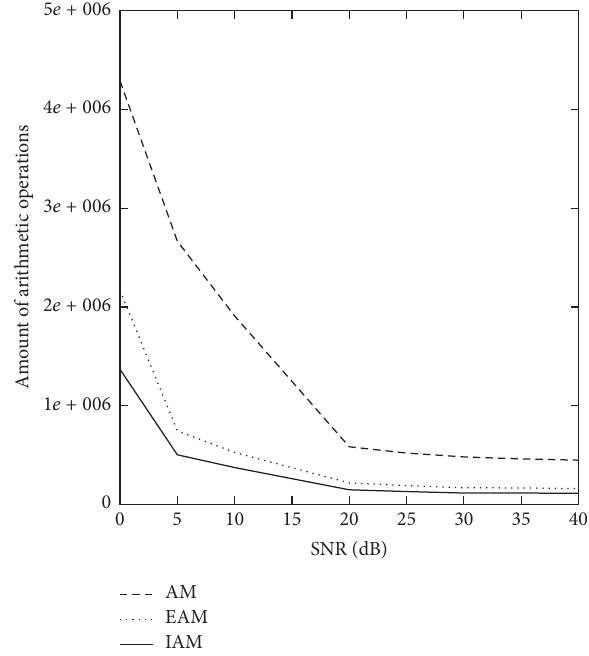
Figure 4: Average amount of operations for AM, EAM, and IAM algorithms. 𝑝 = 3 , 𝑞 = 2 , 𝜂 = 2 .